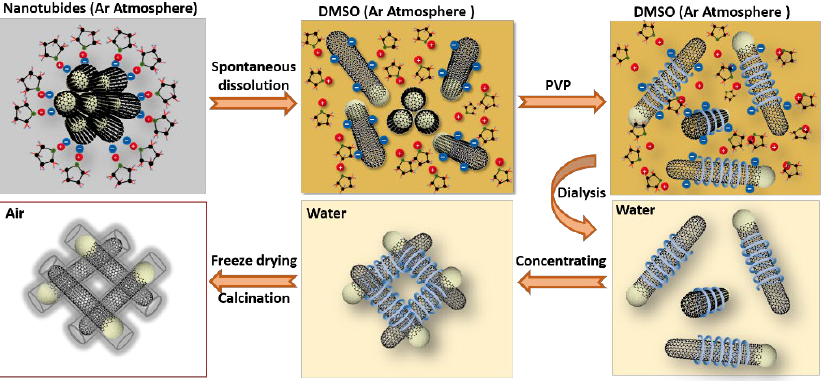
Figure 3. Schematic illustration of the procedure for SWNT dispersion and aerogel preparation.